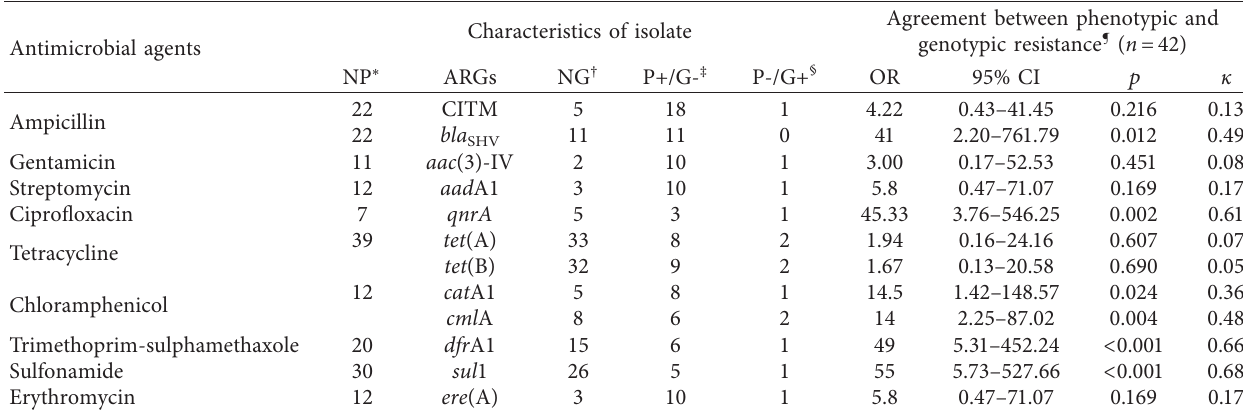
Table 5: Comparative association of antimicrobial resistance in uropathogenic E. coli isolates according to phenotypic and genotypic results. Agreement between phenotypic Characteristics of isolate Antimicrobial agents